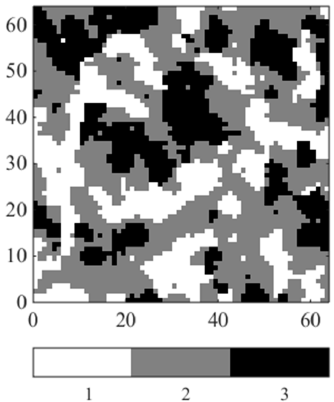
Figure 4. Prediction map generated by MANN with interaction noise. Table 1. Prediction accuracy comparison of the raster data set. µ and σ denote the mean and standard deviation,